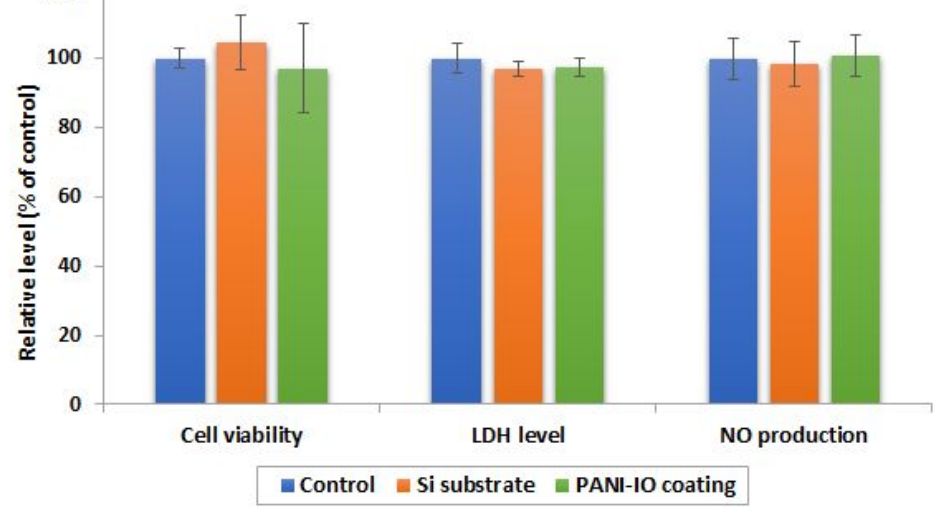
Figure 8. Biocompatibility of Si substrate and PANI-IO coating. The cell viability of Caco-2 cells was assessed by MTT test after 24 h from cell seeding on Si substrate and PANI-IO coating. The LDH level in the culture medium of Caco-2 cells, as a marker of membrane integrity, was estimated through an enzymatic assay based on the LDH-catalyzed conversion of lactate to pyruvate. Nitric oxide (NO) production was measured by Griess reaction method. Results were expressed as mean ± standard deviation (SD) and represented related to control (100%, untreated cells).